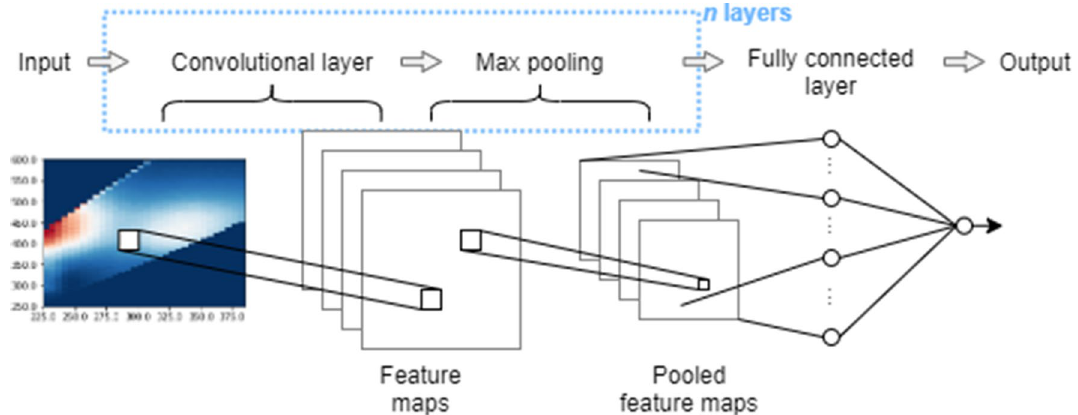
Figure 6. General schematic of convolutional neural network structure. The number of convolutional layers as well as the number of layers (convolution + max pooling) can be